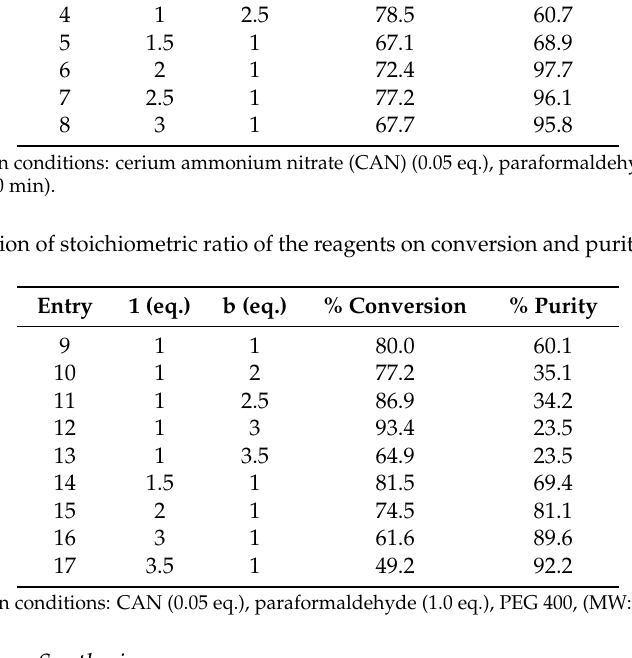
Table 1. Investigation of stoichiometric ratio of the reagents on conversion and purity of compound 1a . Entry 1 (eq.) a (eq.) % Conversion % Purity 1